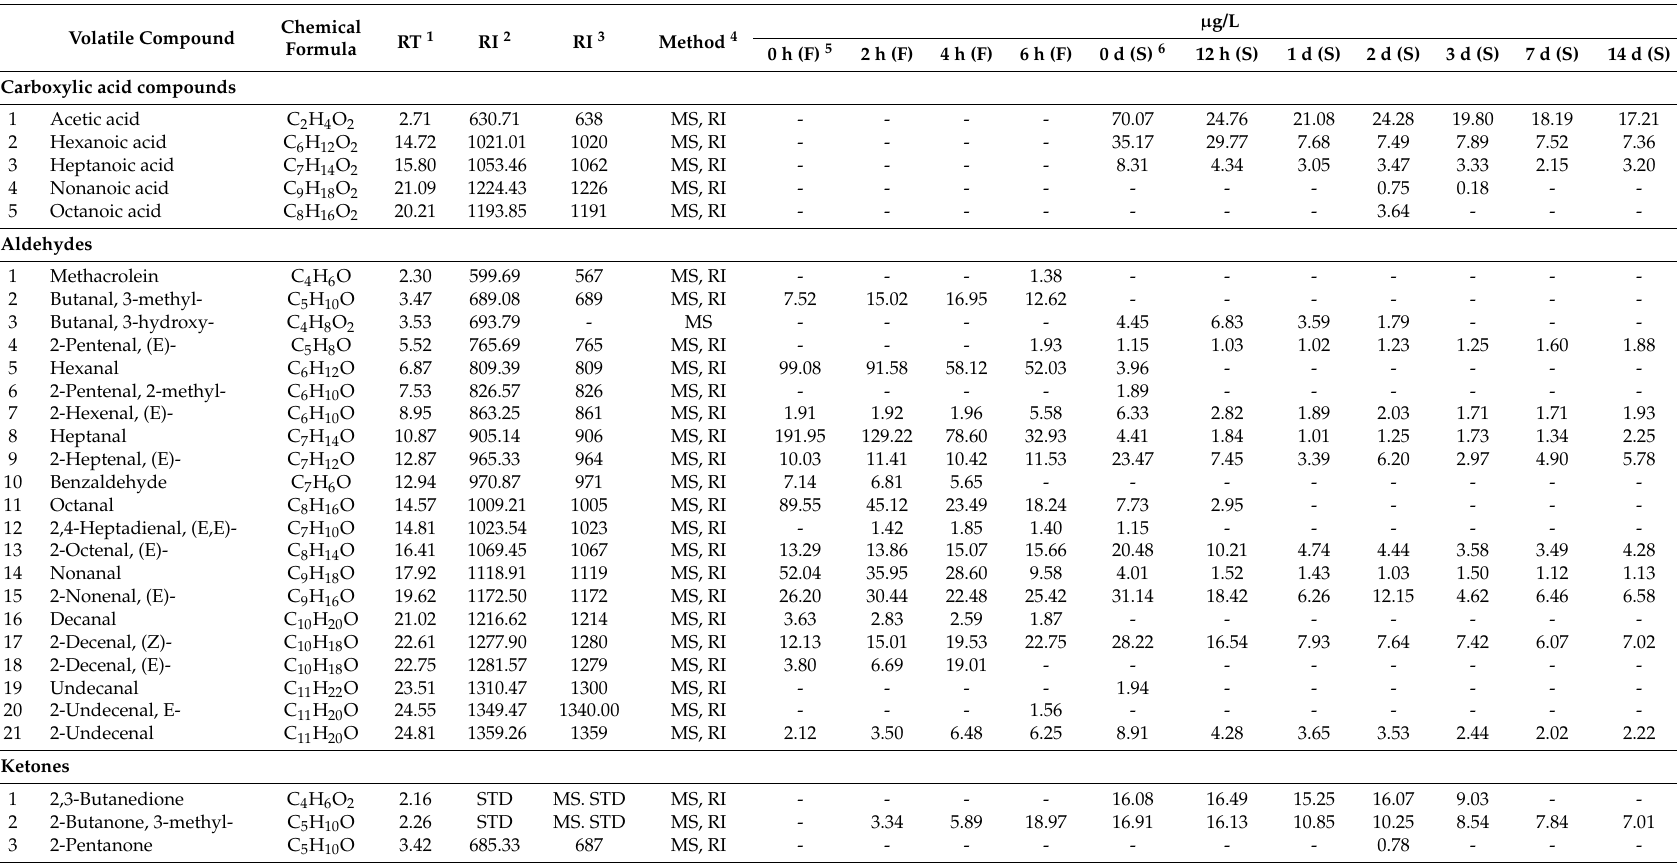
Table 1. Volatile compounds produced in milk fermented by S. thermophilus MGA45-4 during fermentation and